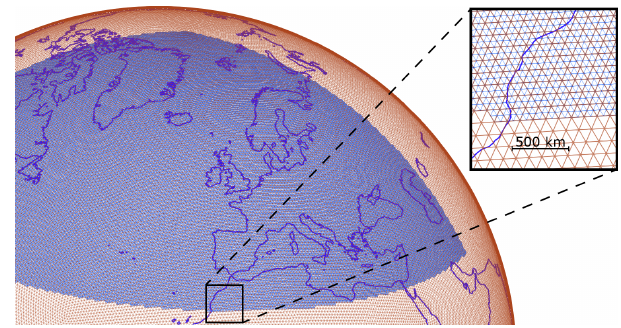
Figure 2. For the POLSTRACC winter, a global ICON-ART sim- ulation with a global R2B6 grid was carried out (red). In the area of the flights, a nest with an R2B7 grid with ∼ 20km horizontal grid spacing was used to resolve mesoscale processes in more de- tail